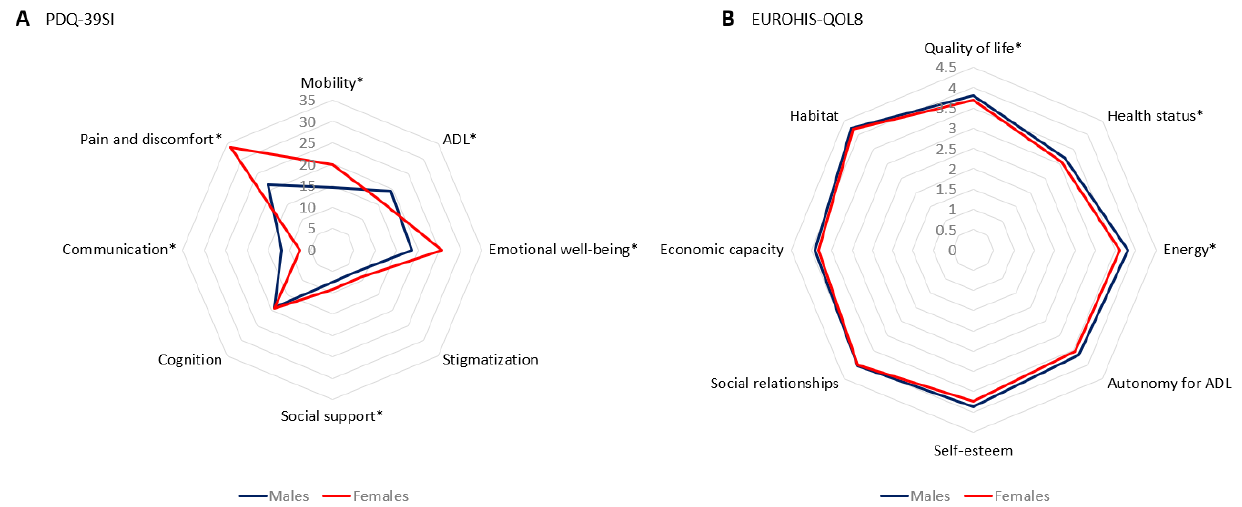
Figure 1. ( A ) Mean score of sub-scores of the UPDRS-III-OFF at baseline in PD males vs. females; *, p < 0.0001. ( B ) Mean score on each domain of the NMSS at baseline in PD males vs. females; *, p < 0.05; Sleep/fatigue, p = 0.041; Mood/apathy, p = 0.003; Urinary symptoms, p = 0.047; Miscella- neous, p = 0.010.